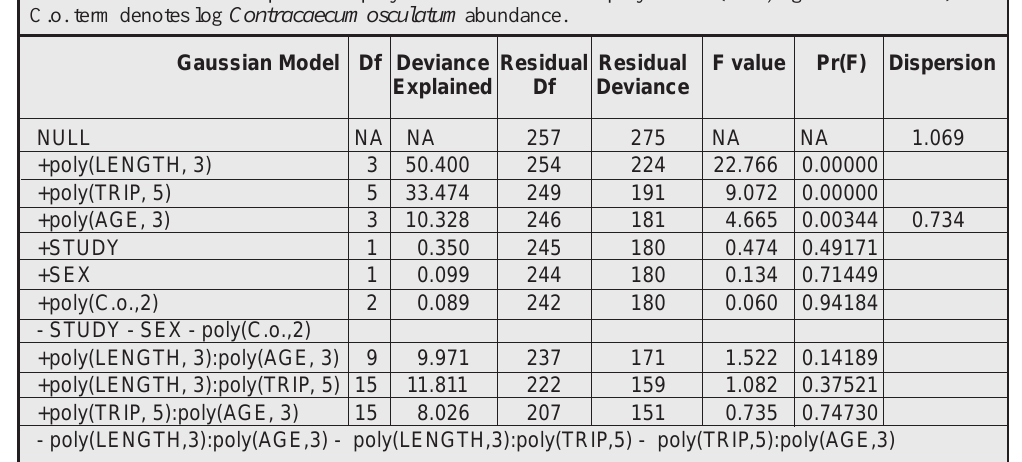
Table 7 . Analysis of deviance of log Pseudoterranova decipiens abundance in adults. Terms in italics not re- tained in final model. The preceder “poly” defines the term as a polynomial (term,degrees of freedom). The C.o. term denotes log Contracaecum osculatum abundance.